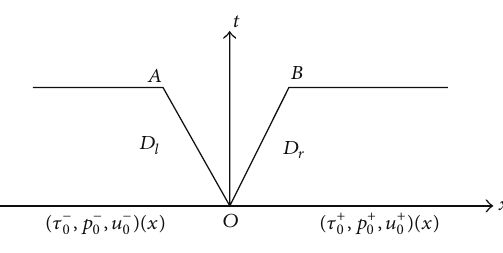
Figure 6: The discussed